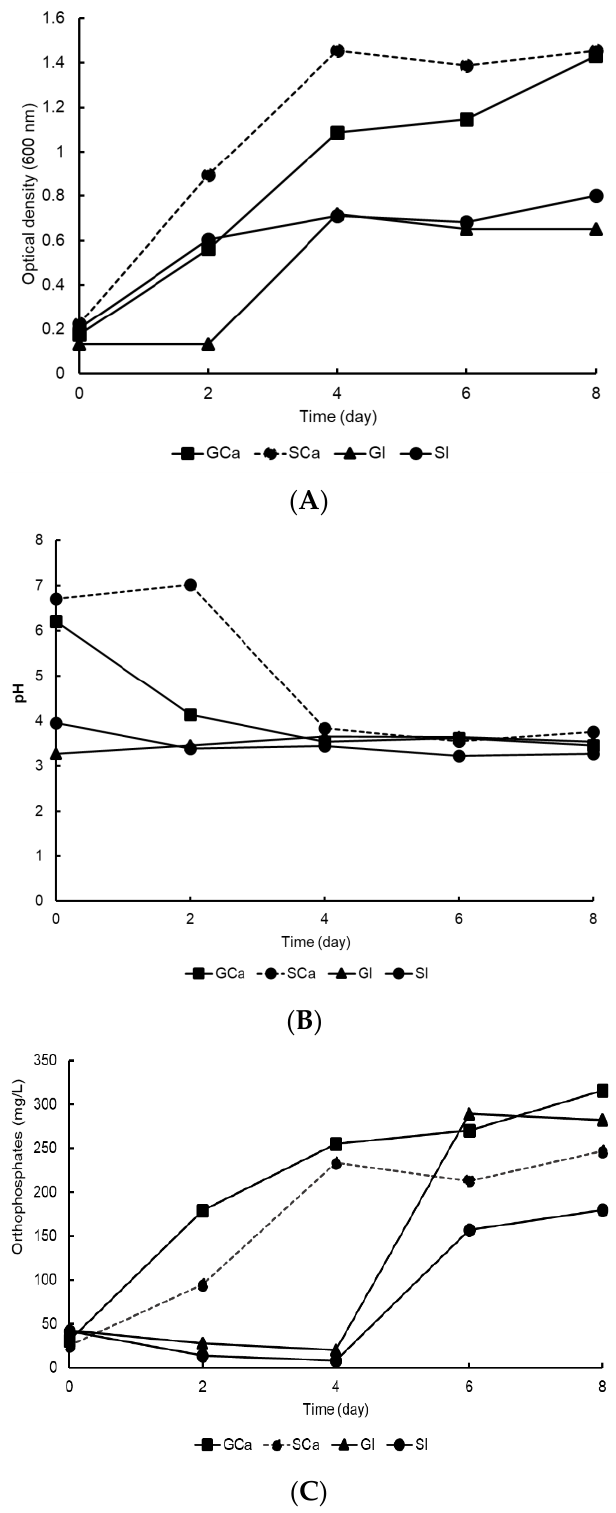
Figure 3. Growth, pH, and P solubilization by the A3 bacterial strain, with glucose or sucrose in PVK medium. ( A ) Bacterial growth measured by optical density. ( B ) Dynamics of pH values. ( C ) P